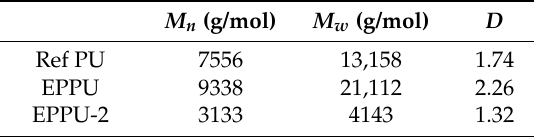
Figure 4. GPC data for polyurethanes, intensity (arbitrary unit) vs retention time (min)). Table 1. Molecular weights of polyurethanes.